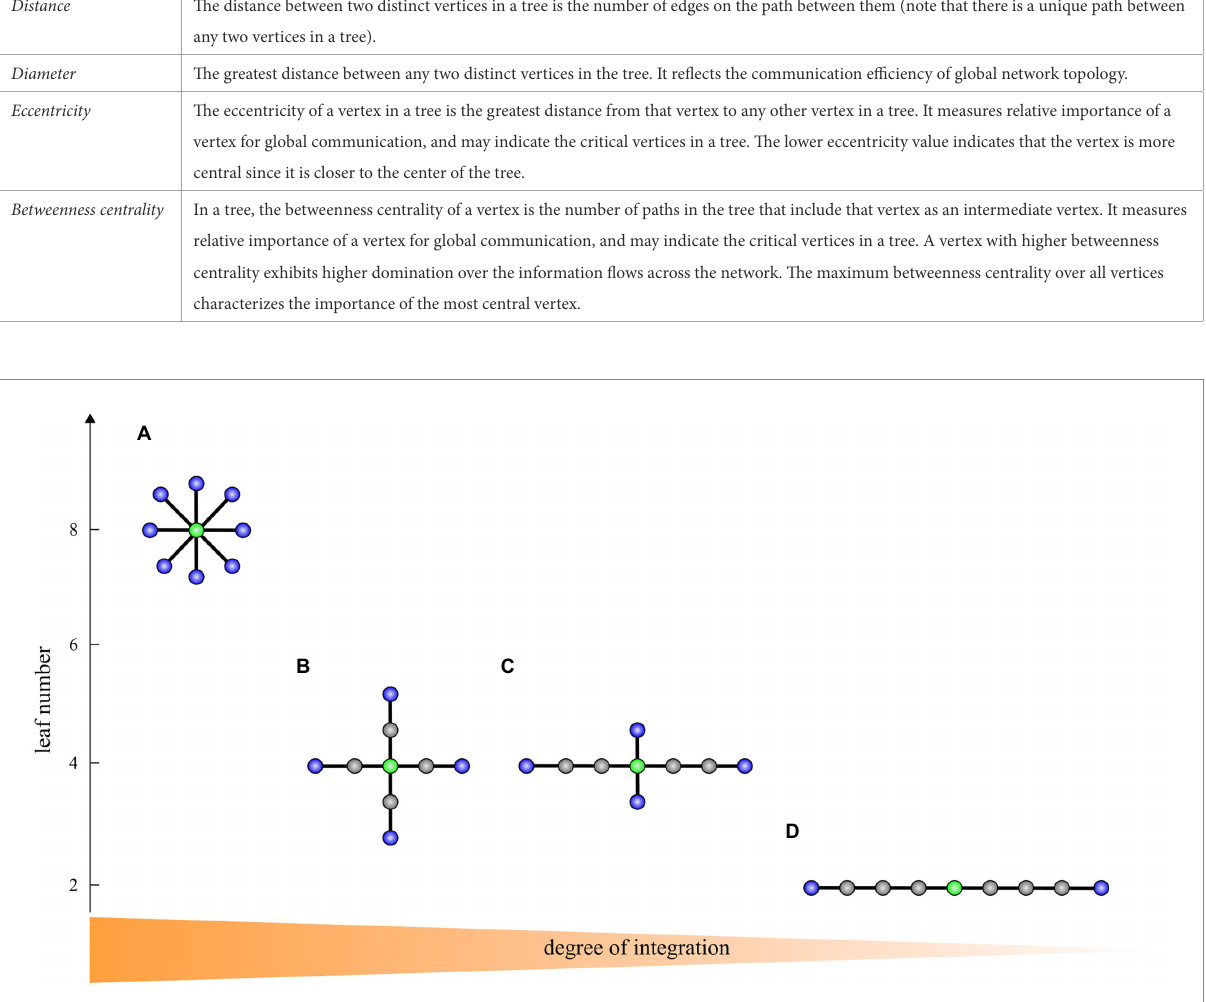
FIGURE 1 A transition from a star-like topology (A) to a path-like topology (D) with two intermediate topologies (B,C) corresponding to the brain network integration from highest to lowest on trees with nine vertices. Blue vertices: leaves. Green vertices: vertices with the highest betweenness centrality and lowest eccentricity representing the most critical/central vertices in the tree. In A , the leaf number is 8, the diameter is 2, the maximum betweenness centrality is 28, and the mean eccentricity is 1.9. In B , the leaf number is 4, the diameter is 4, the maximum betweenness centrality is 24, and the mean eccentricity is 3.3. In C , the leaf number is 4, the diameter is 6, the maximum betweenness centrality is 22, and the mean eccentricity is 4.6. In D , the leaf number is 2, the diameter is 8, the maximum betweenness centrality is 16, and the mean eccentricity is 6.2. The figure is adapted from van Lutterveld et al. (2017).